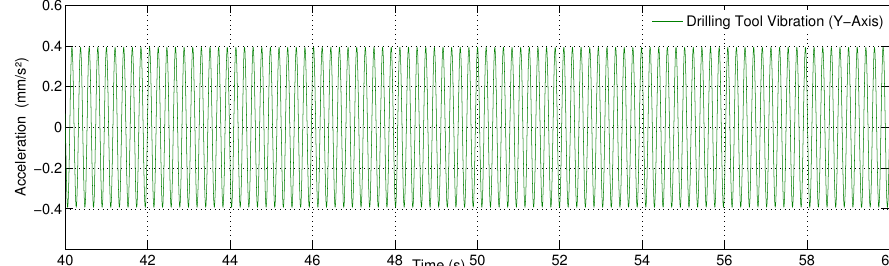
Figure 7. Drill Tool vibration along the y-direction.